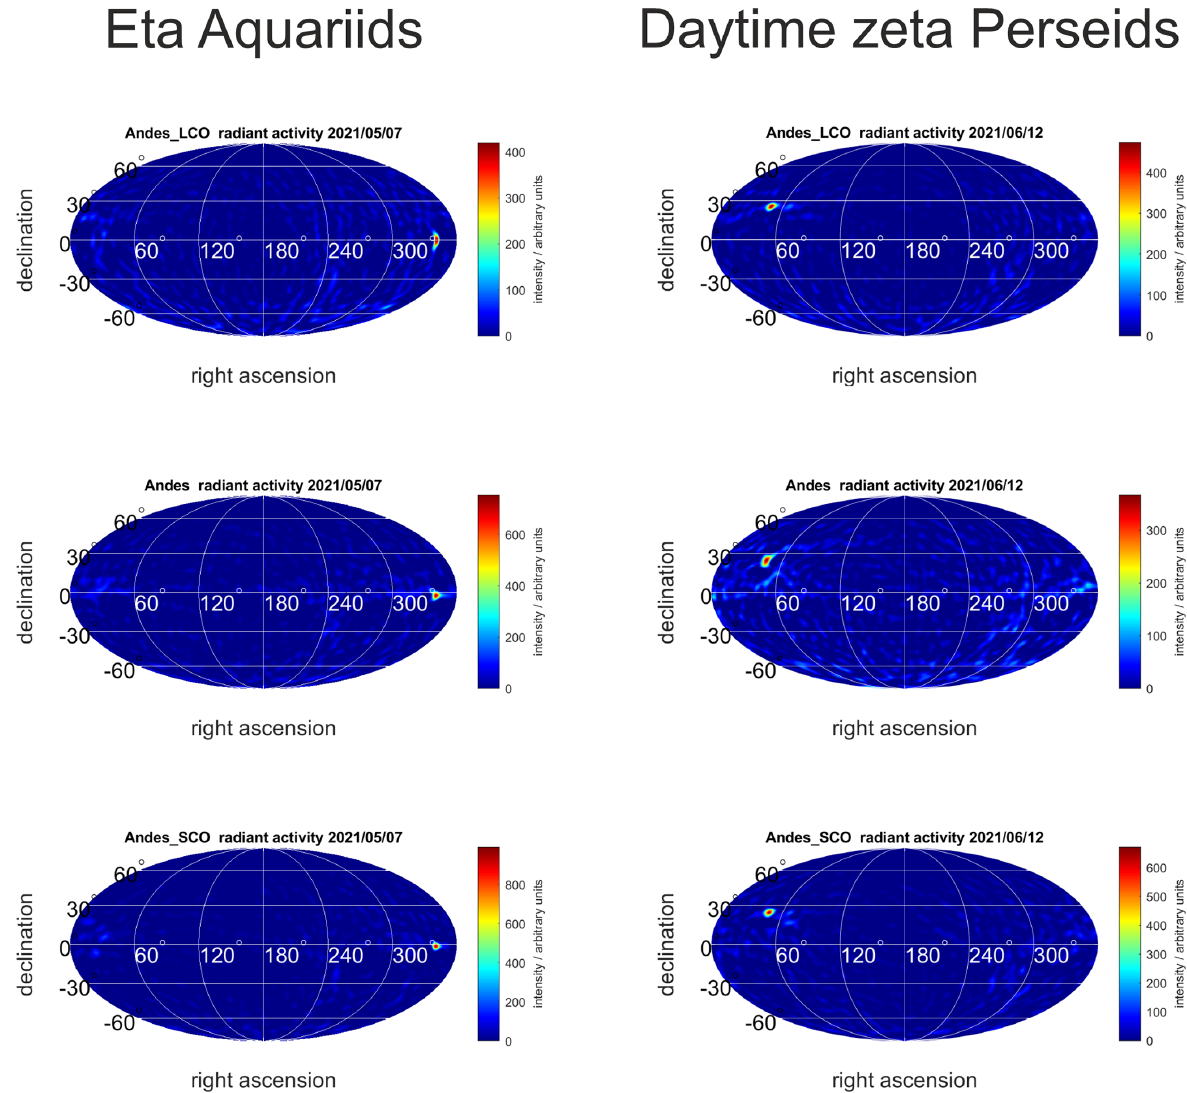
Figure 4. Meteor radiant activity maps derived from CONDOR for LCO, ALO (Andes), and SCO (the top, middle, and bottom row, respec- tively) . The left column shows the source radiant activity for the η Aquariids, and the right panels present the daytime zeta Perseids. The meteor showers are identified from the catalogues presented in Brown et al. (2010) and Janches et al.